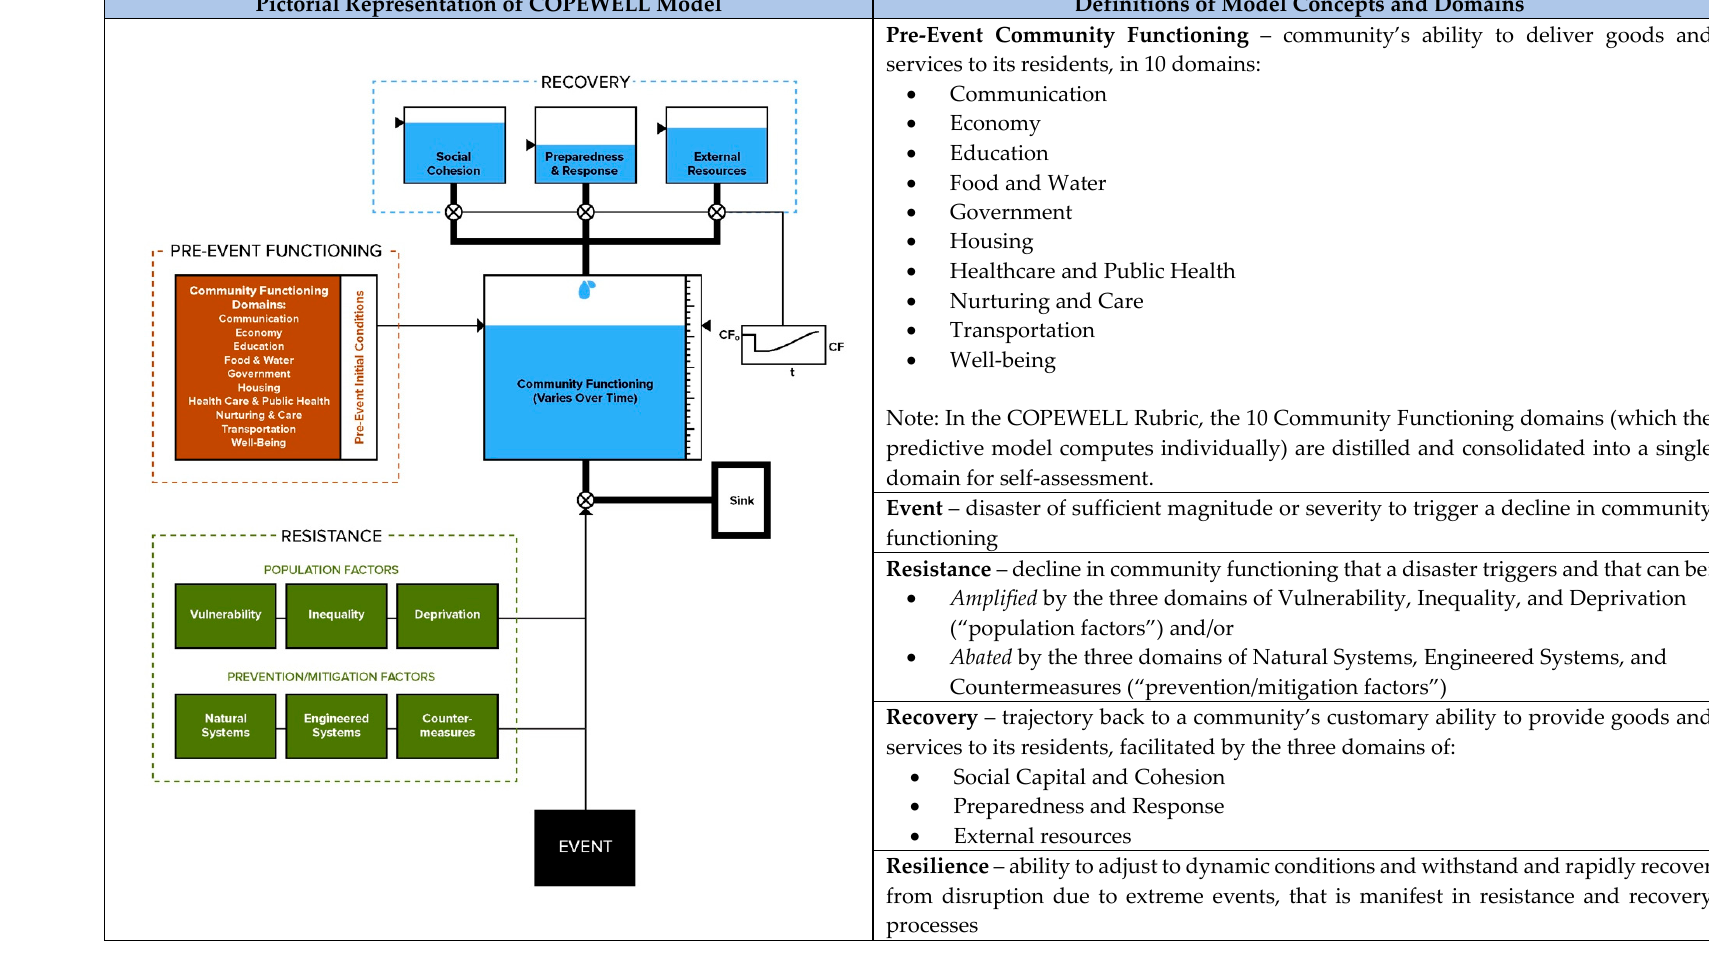
Figure 1. Composite of Post-Event Well-being (COPEWELL), A Conceptual and Computational Model for Predicting Post-Disaster Community Functioning and Resilience–Pictorial and Prose Representations (Adapted from References [35,36]).